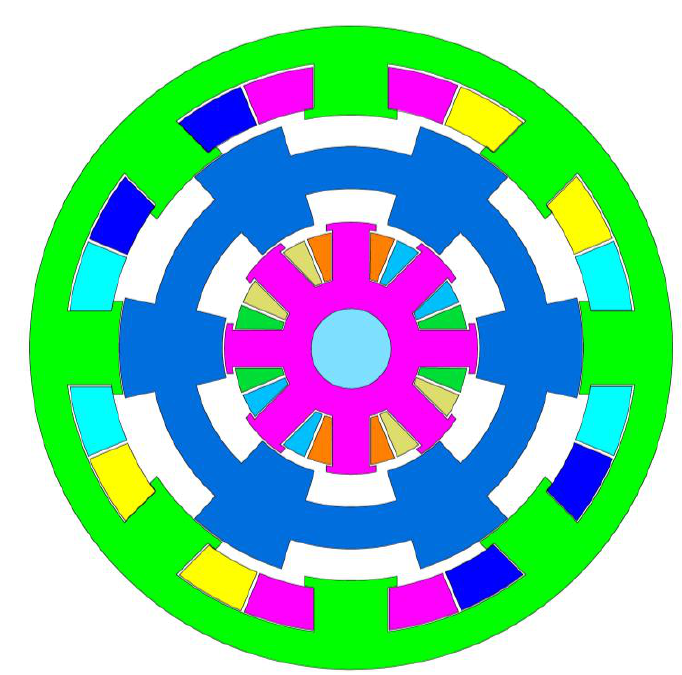
Figure 6. 2D FEA model of